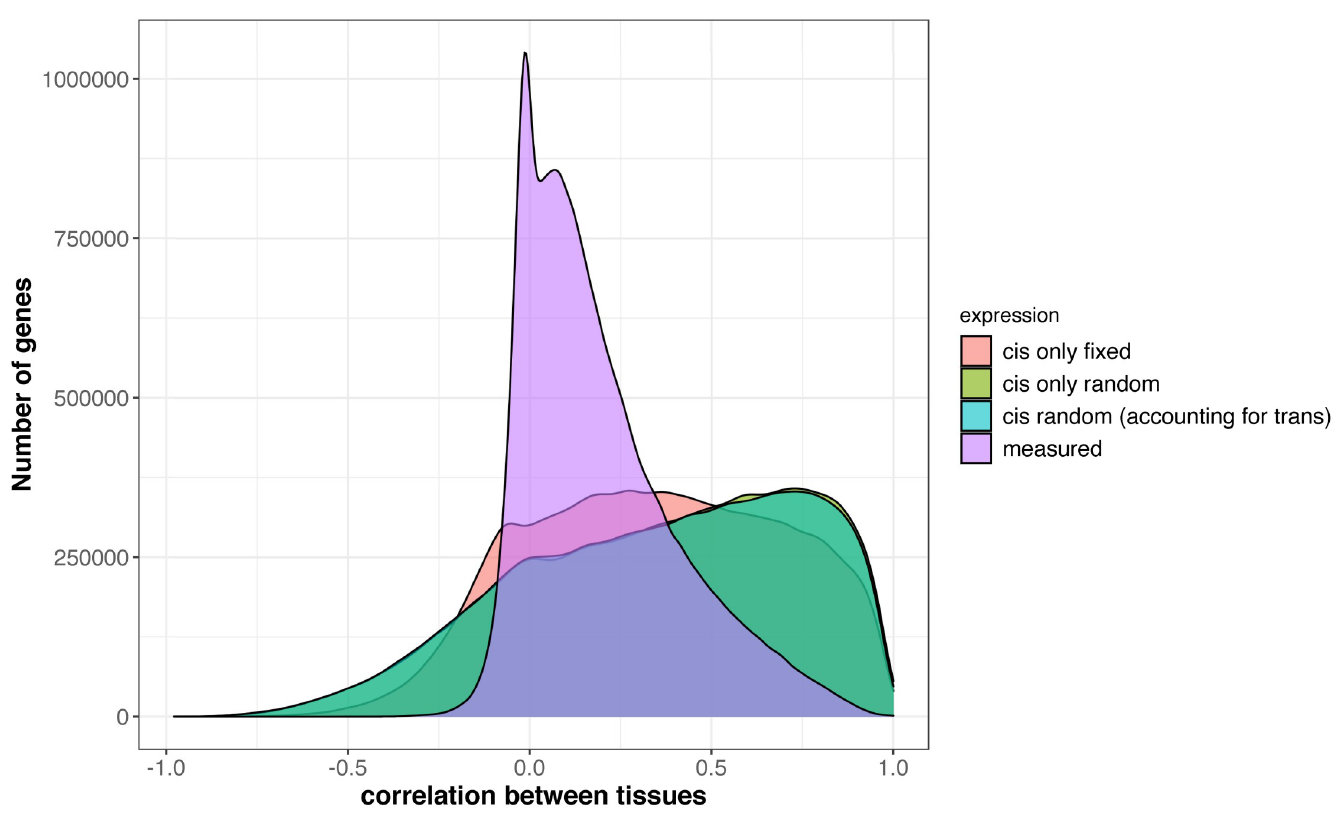
Fig 4. Haplotype associated RNA expression (HARE) was highly correlated across tissues as compared to measured transcript expression. Different colors represent HARE imputed from 3 statistical models: Model 1 ( cis fixed effect), 2 ( cis random effect), and 3 ( cis + trans random effects), and measured transcript expression. The distribution is pairwise correlation of genes across 21 different combinations from 7 different